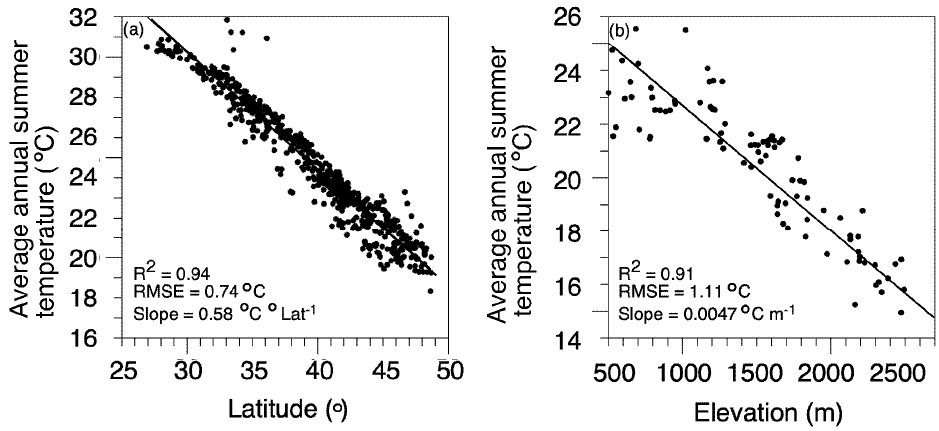
Figure 8. ( a ) Average summer water temperatures of United States lakes located between latitudes of 26 ◦ N and 49 ◦ N and at elevation less than 500 m. ( b ) Average summer water temperatures of United States lakes located between latitudes 37 ◦ N and 42 ◦ N and at elevations greater than 500 m.